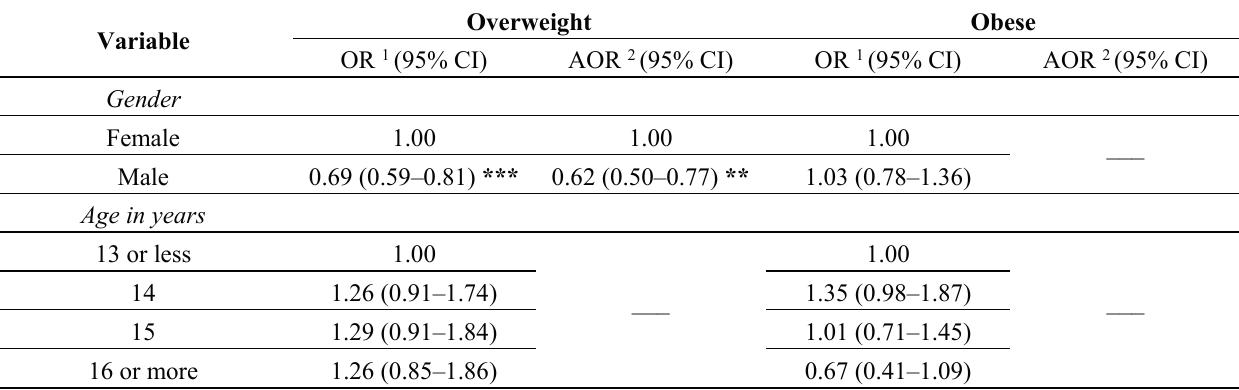
Table 2. Overweight and obesity regression